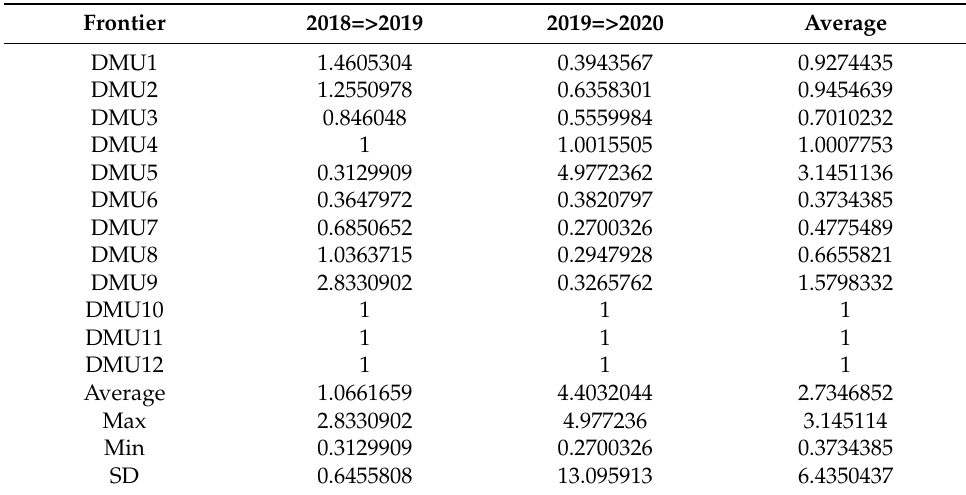
Table 13. The technical (frontier-shift) changes level over the period from 2018 to 2020.